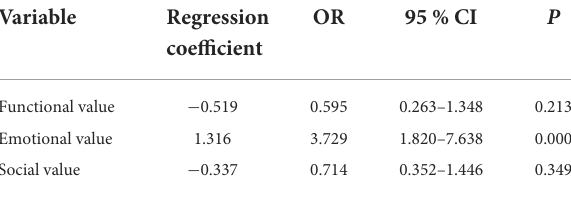
TABLE 6 Summary of logit regression analysis